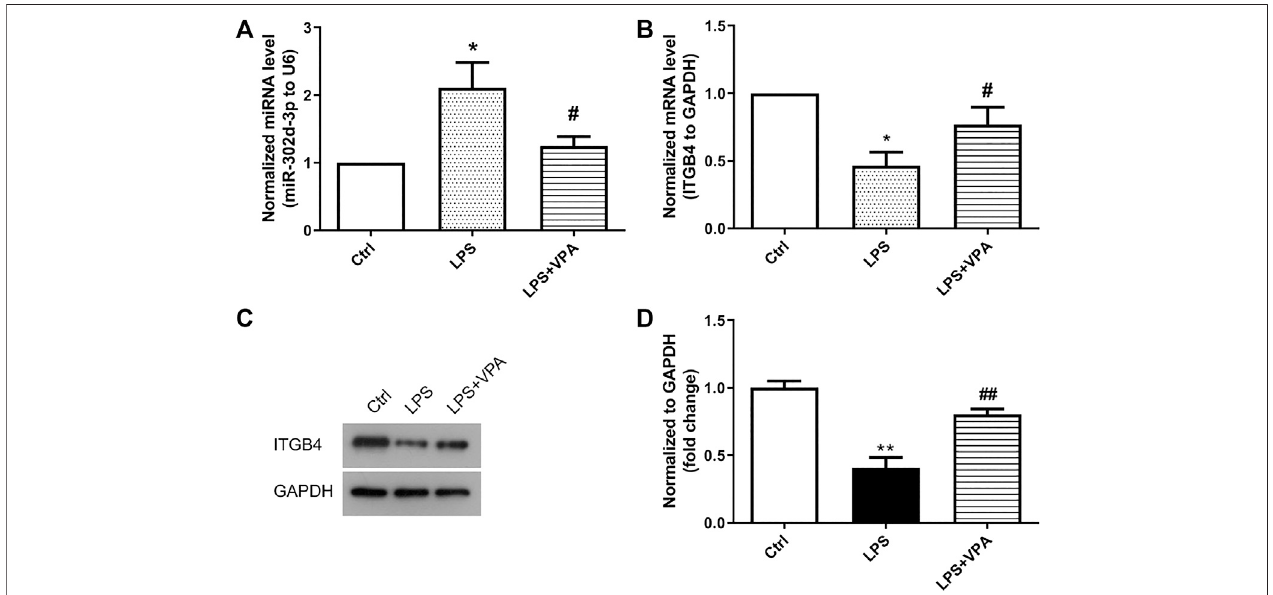
FIGURE 5 | VPA treatment decreases the expression of miR-302d-3p but elevates the expression of ITGB4 in OA cells. (A) Effect of VPA treatment on the expression of miR-302d-3p in LPS-treated CHON-001 cells through qRT-PCR assay. * p < 0.05, # p < 0.05. (B) qRT-PCR analysis was used to determine the impact of VPA on the ITGB4 mRNA expression in OA cells. * p < 0.05, # p < 0.05. (C,D) The ITGB4 protein expression was examined using western blot and quanti fi ed via the normalization to GAPDH. ** p < 0.01, ## p < 0.01. Results are the average of three individual experiments in triplicate with error bars indicating mean ± SD (ANOVA followed by Tukey ’ s post hoc